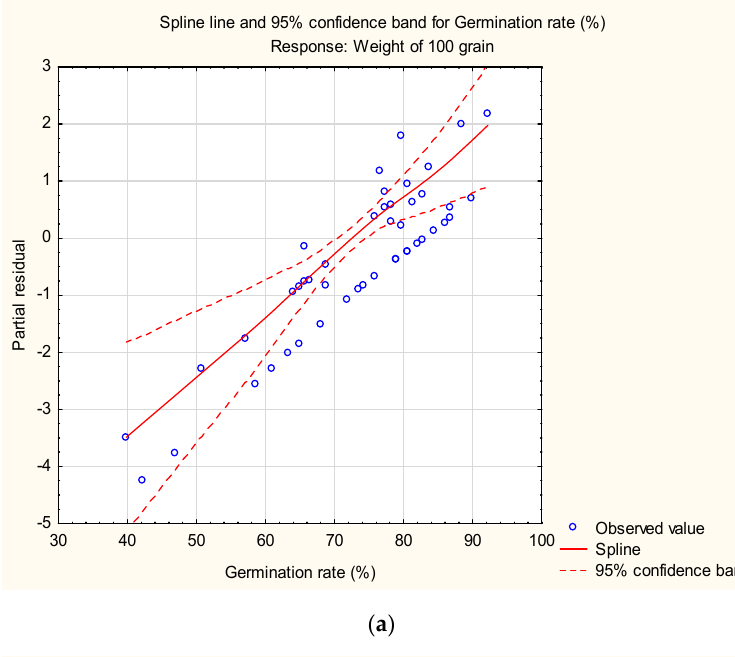
Figure 5. DCA quoted results for studied parameters between treated (red squares) and untreated (green diamonds) plant with insecticide. First axis explained 27.29% of variance and the second axis explained 23.40% of all the total variance.